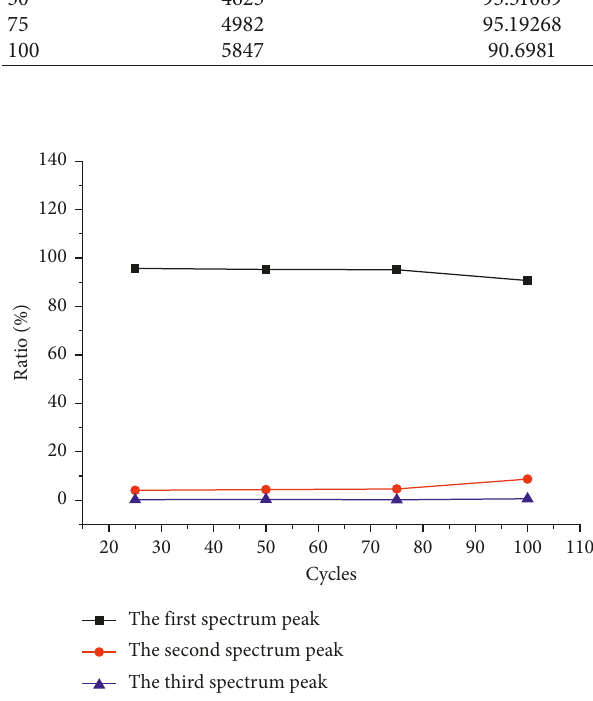
Figure 6: NMR characteristics and mechanical properties of ce- 2 ment mortar during freeze-thaw cycles.